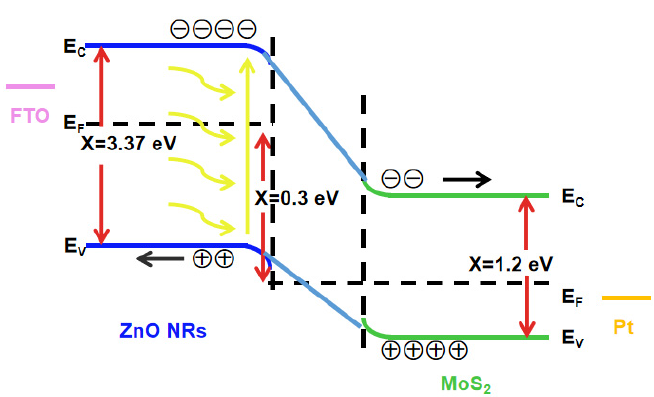
Figure 6. Energy band schematic diagram of ZnO@MoS 2 receiving light to form photogenerated carriers under an external bias voltage.